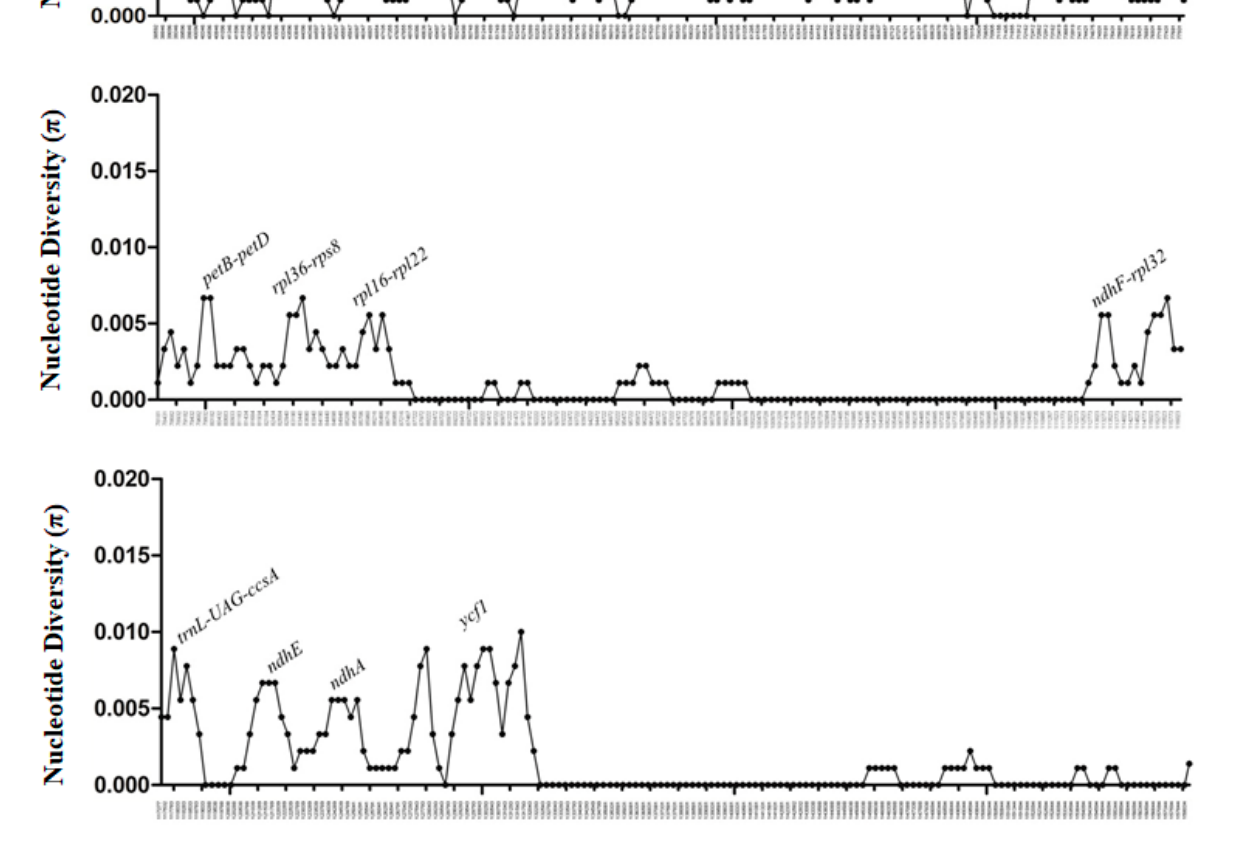
Figure 4. Sliding 600 bp window analysis of the six Ilex chloroplast genomes showing nucleotide diversity ( π ). Regions with π > 0.005 are indicated in the graph. X -axis, positions of the midpoints of windows; y -axis, nucleotide diversity of each window.